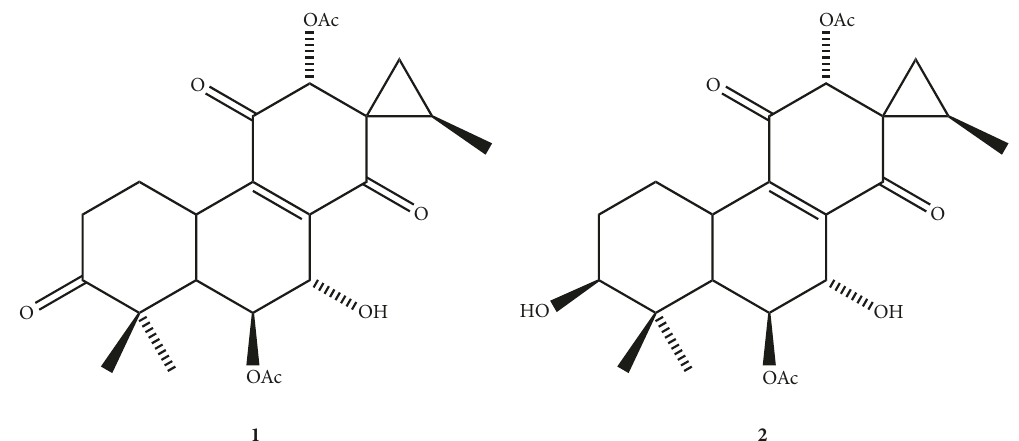
Figure 1: Chemical structures of barbatusin ( 1 ) and 3 𝛽 -hydroxy-3-deoxybarbatusin ( 2 ).